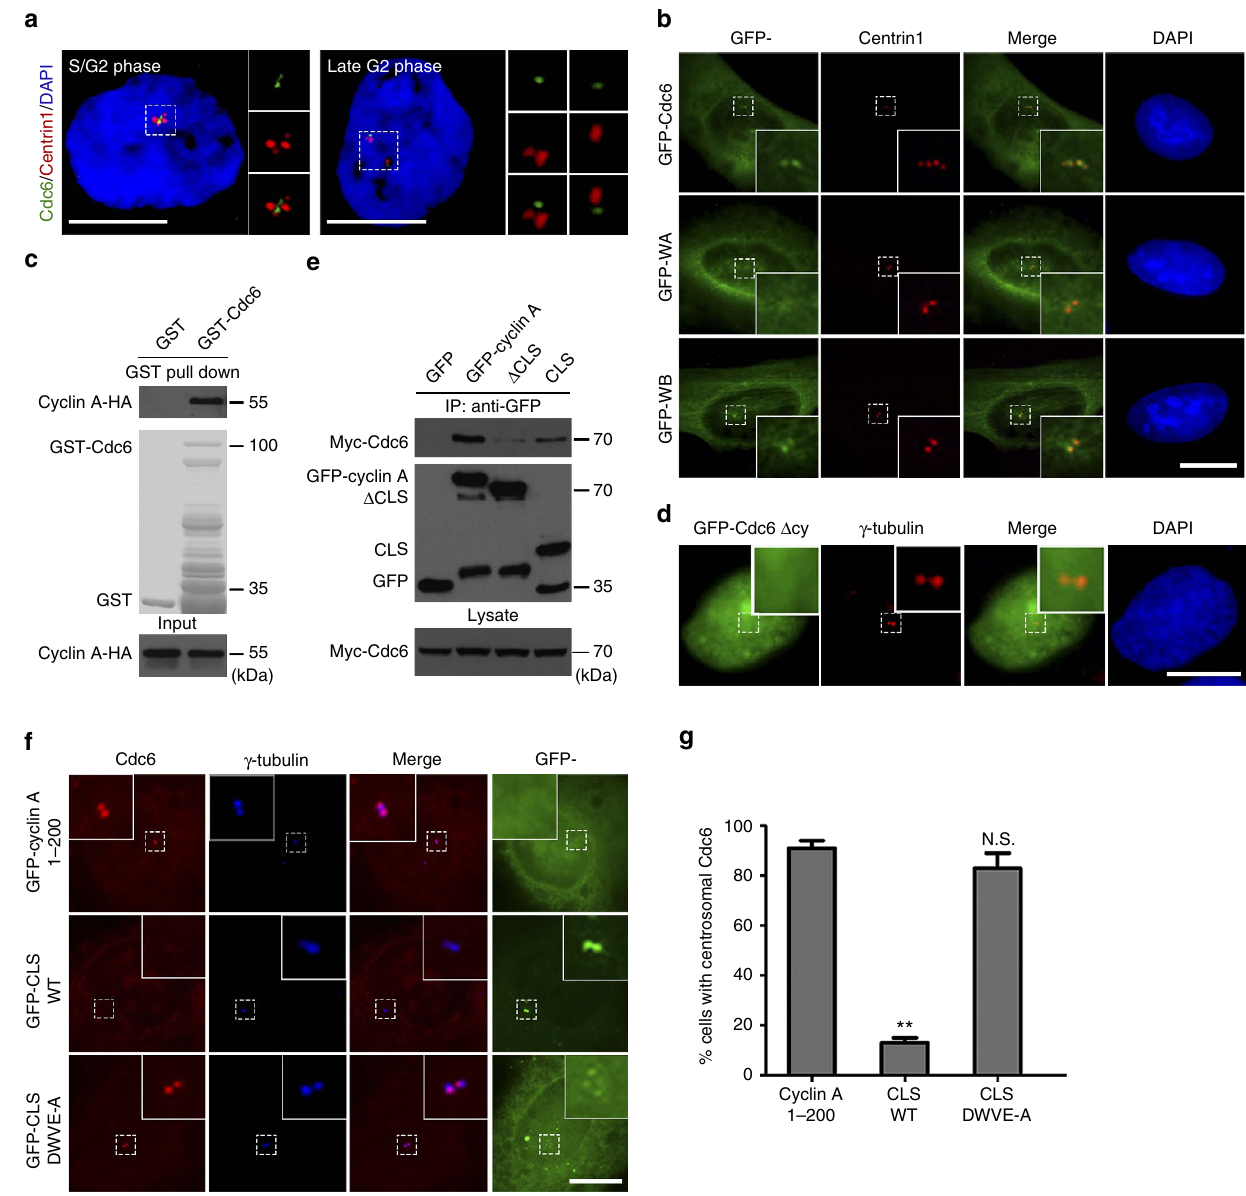
Figure 1 | Cyclin A mediates the localization of Cdc6 on the proximal side of the centrioles. ( a ) Cdc6 localizes on the proximal side of centrioles during S and G2 phases. Immunofluorescence showing localization of endogenous Cdc6 (green) and centrin1 (red) in U2OS cells. We defined cells with four contiguous centrin-positive dots as S/G2 phase cells, and cells with two pairs of very distant centrin-positive dots as late G2 phase cells. ( b ) Cdc6 or WB mutant, but not WA mutant, localizes on centrioles. U2OS cells were transfected with GFP-tagged Cdc6 WT, WA or WB mutant and stained with a centrin1 antibody. ( c ) Cdc6 directly binds cyclin A in vitro . Sepharose beads coupled with purified GSTor GST-tagged Cdc6 were incubated with in vitro transcribed and translated HA-tagged cyclin A and analysed by western blotting using a HA antibody. The loading of GSTand GST-tagged Cdc6 proteins are shown by Coomassie blue staining. ( d ) Cytoplasm and centrosomal localization of Cdc6 requires the interaction between Cdc6 and cyclin A. U2OS cells were transfected with GFP-tagged Cdc6 D cy and stained with a g -tubulin antibody. ( e ) Interactions between Cdc6 and centrosomal localization signal (CLS) domain, or CLS deletion mutant ( D CLS) of cyclin A are reduced compared to WTcyclin A. HEK293 cells were co-transfected with Myc-tagged Cdc6 and GFP-tagged cyclin AWT, D CLS or CLS truncate. The total cell extract was used for immunoprecipitation with a GFP antibody and western blotting with Myc and GFP antibodies. ( f ) The centrosomal localization of cyclin A is required for the centrosomal recruitment of Cdc6. U2OS cells expressing GFP-tagged truncates of cyclin A (amino acids 1-200, CLS or CLS mutant DWVE-A) were stained with Cdc6 and g -tubulin antibodies. ( g ) Quantitation of cells with centrosomal Cdc6 in f . Approximately 300 cells were counted per sample, and three independent experiments were conducted. Data are presented as means ± s.d. ** P o 0.01; N.S., no significant difference (Student’s t -test). DNA was stained with DAPI. Scale bars, 10 m m. Insets in a , b , d and f are high- magnification views of the regions indicated in the low-magnification